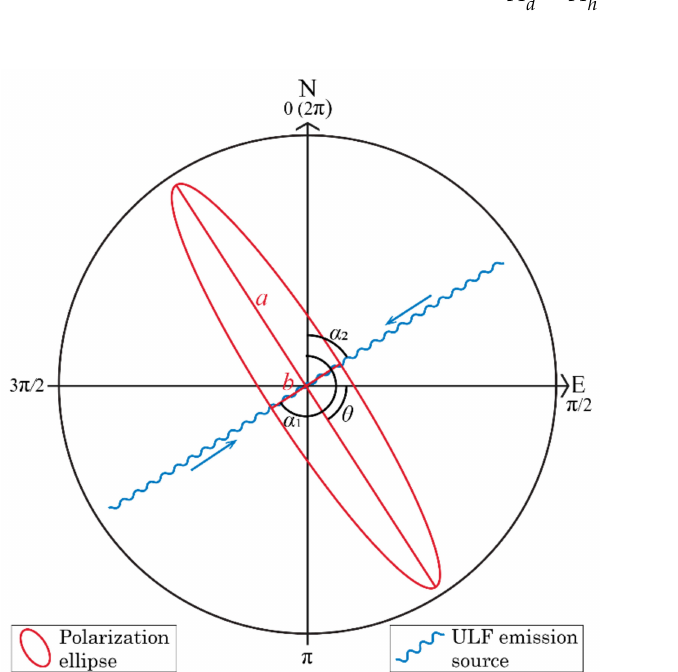
Figure 2. Illustration of the polarization ellipse and possible directions of the ultra-low frequency (ULF) emission